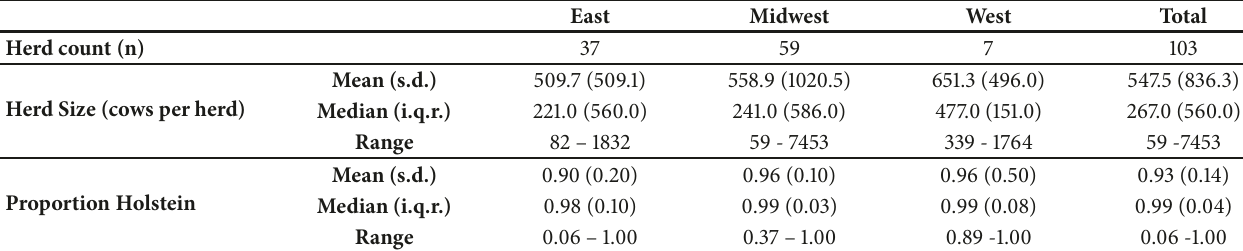
Table 1: Characteristics of enrolled herds from herd records; s.d.: standard deviation; i.q.r.: interquartile range.